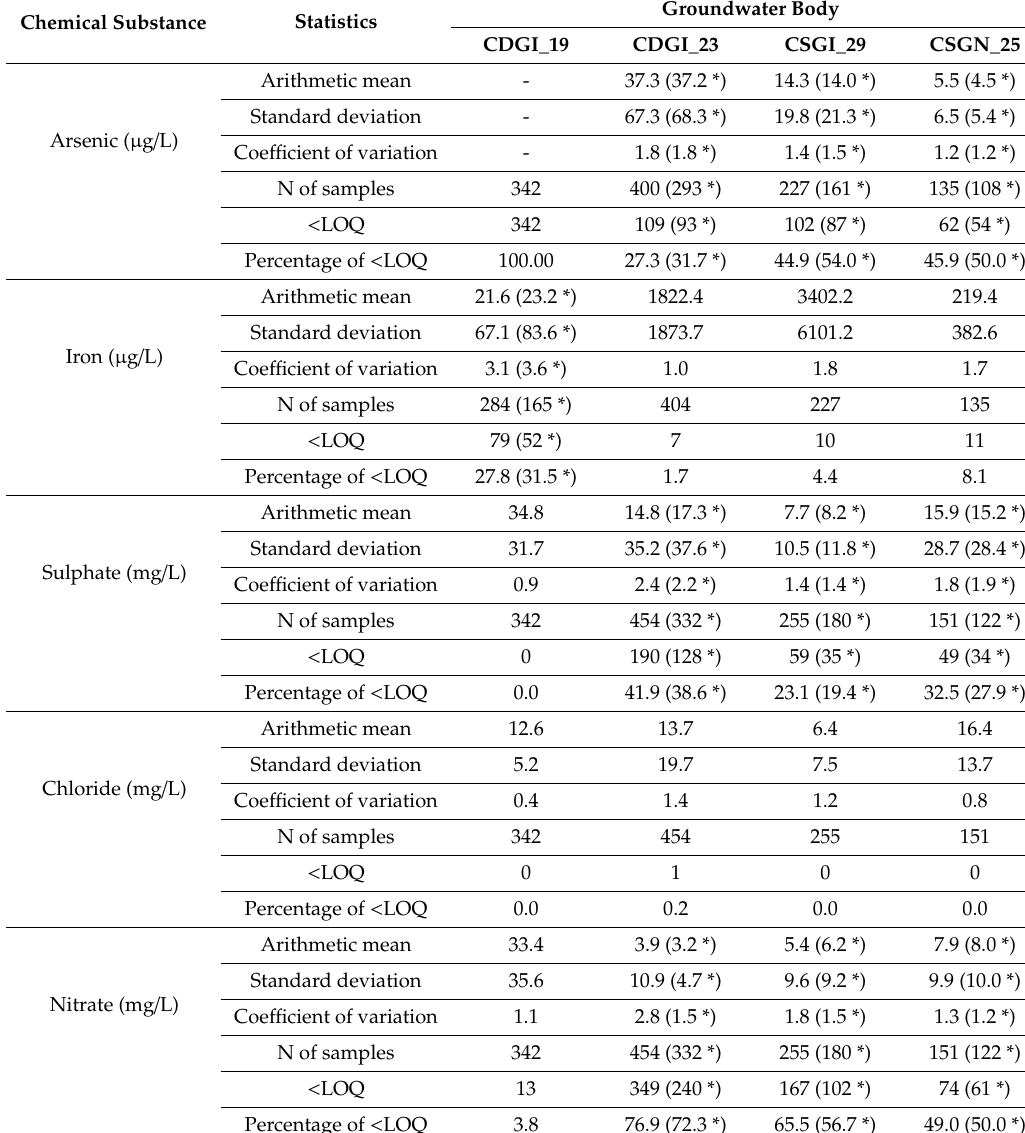
Table 2. Main statistics for analysed